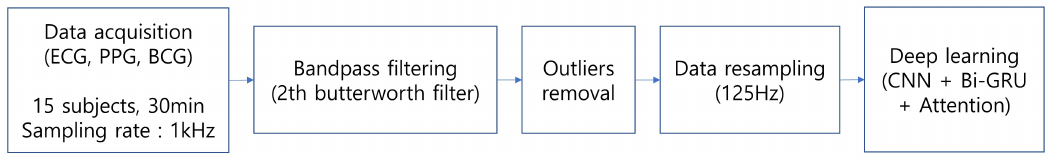
Figure 1. Brief flow chart of our